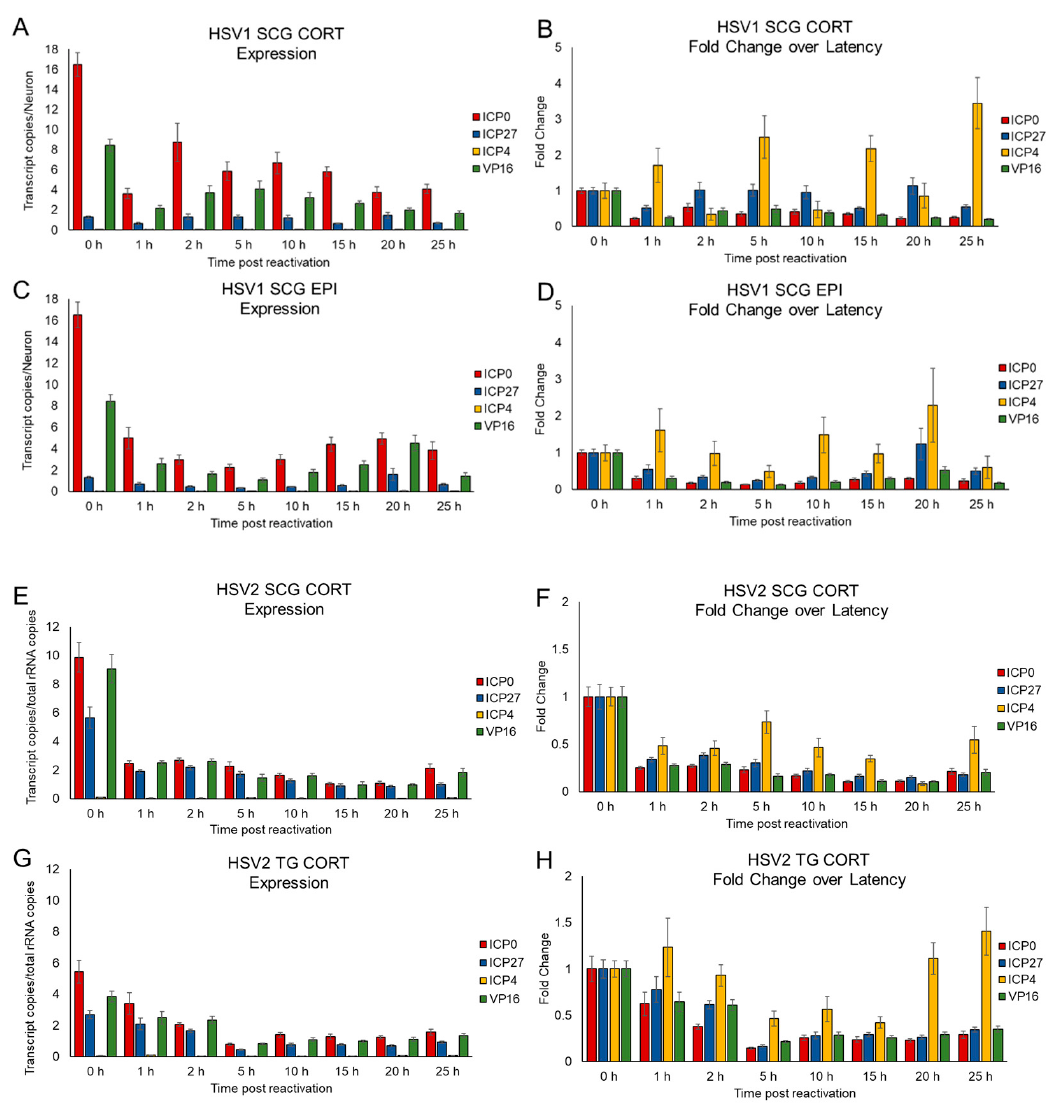
Figure 5. HSV gene expression in primary SCG and TG neuronal cultures during EPI- and CORT- induced reactivation. Primary adult neuronal cultures from sympathetic SCG and sensory TG infected with HSV-1 or HSV-2 for 7 days in the presence of acyclovir to establish latency were treated with epinephrine (EPI) or corticosterone (CORT) to induce reactivation. Total RNA was extracted at the designated timepoints post-reactivation, and viral gene transcripts for ICP0, ICP27, ICP4, and VP16 were quantified by ddPCR. ( A ) HSV-1 in SCG treated with CORT, presented as gene transcript copies per neuron. ( B ) HSV-1 in SCG treated with CORT, presented as fold-change compared to each gene expressed during latency with no treatment and no removal of acyclovir (0 h). ( C ) HSV-1 in SCG treated with EPI, as gene transcripts per neuron. ( D ) HSV-1 in SCG treated with EPI, as fold-change compared to each gene expressed during latency (0 h). ( E ) HSV-2 in SCG treated with CORT, as gene transcript copies per neuron. ( F ) HSV-2 in SCG treated with CORT, as fold-change compared to each gene expressed during latency (0 h). ( G ) HSV-2 in TG treated with CORT, as gene transcripts per neuron. ( H ) HSV-2 in TG treated with CORT, as fold-change compared to each gene expressed during latency (0 h). Data are means ± SEM, n > 6 experiments.